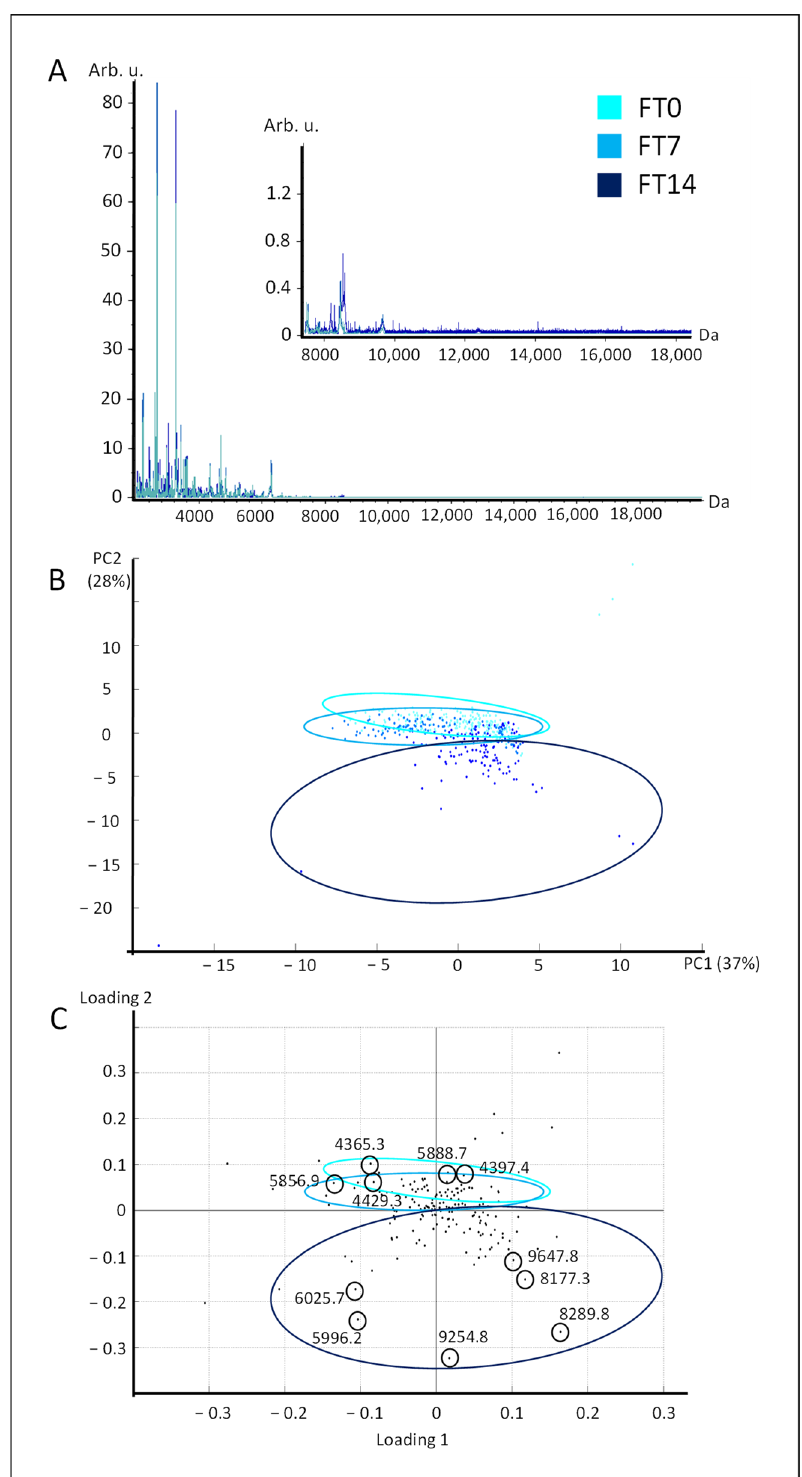
Figure 2. Spectral analysis of frozen–thawed livers stored for 0, seven, and 14 days. Mean protein spectra ( A ) from frozen–thawed livers stored 0 (FT0, in light blue), 7 (FT7, in blue), and 14 days (FT14, in dark blue). B. Score plot ( B ) and loading plot ( C ) of the PCA of protein spectra from frozen–thawed livers stored for 0, seven, and 14 days.